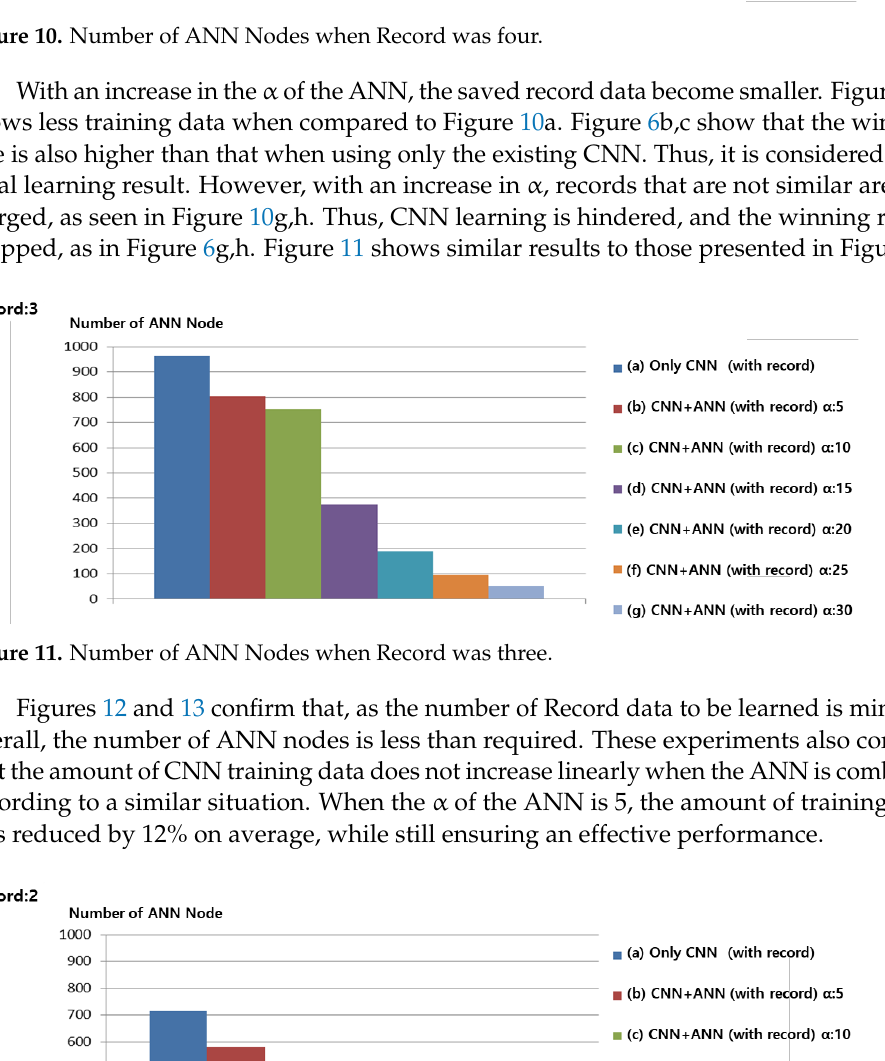
Figure 10. Number of ANN Nodes when Record was four.